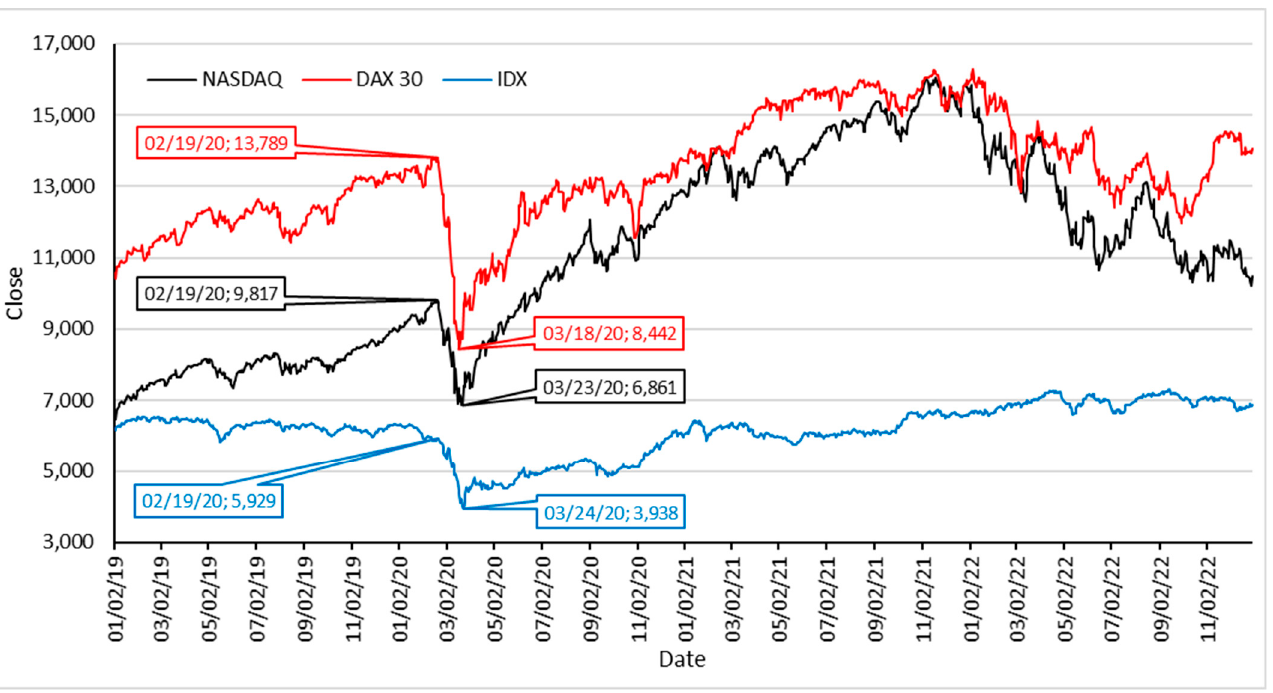
Figure 1. Stock index movements during the pandemic.